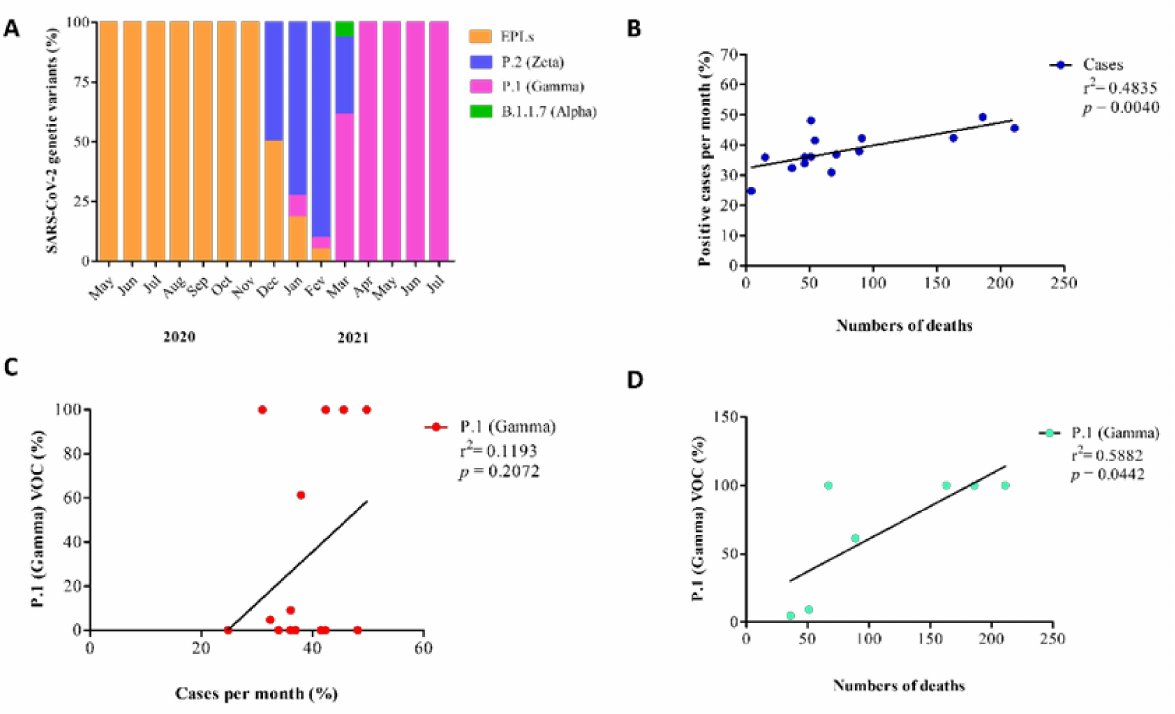
Figure 4. Substitution of SARS-CoV-2 lineages and its impact on local health. ( A ) Proportions of SARS-CoV-2 lineages found during the period of study. Viruses were classified based on genome sequencing and a specific RT-qPCR strategy capable of detecting specific mutations, as described in Section 2. EPLs, early pandemic lineages of SARS-CoV-2. ( B ) association between proportions of numbers of cases per month and numbers of deaths per month, as confirmed by linear regression analysis. ( C ) lack of association between proportions of viruses of the Gamma lineage found per month and proportions of cases per month (confirmed by linear regression analysis). ( D ) association between proportions of viruses of the Gamma lineage found per month and numbers of death per month (confirmed by linear regression analysis). Statistical significance was set as p ≤